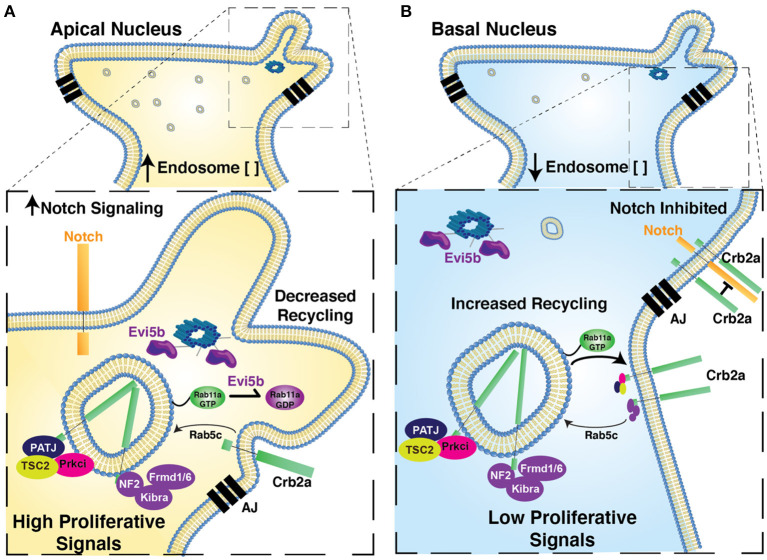
Proposed model for relationship of Nuclear Position, endosome activity, and the regulation of polarized signaling and retinal neurogenesis. Model figure suggesting the functional significance of nuclear position in the regulation of apical endosome concentration, Rab11a recycling endosome activity, the regulation of Crb2a apical protein localization and the regulation of autonomous signaling. In cells with apical nuclei (A) we suggest apical concentration of Rab11a-positive recycling endosomes biases a state in which Rab11a is preferentially in the inactive, GDP-bound form, due to the close proximity of apical recycling endosomes to the centrosome-localized Rab11a-GAP, Evi5b. This in turn decreases recycling of Crb2a to the apical junctions, thereby decreasing the cis-inhibition of Notch signaling by Crb2a (increased Notch signaling) and mis-localizing Crb2a interacting proteins from the apical junction. Combined these changes promote autonomous signaling to promote a proliferative state. In cells with basal nuclei (B) Rab11a is preferentially in a GTP-bound active state, promoting Crb2a recycling, inhibiting Notch-signaling, and maintaining apical localization of Crb2a-interacting proteins. In combination, this biases cells toward an autonomous signaling state that promotes neurogenesis. AJ, Apical Junctions.